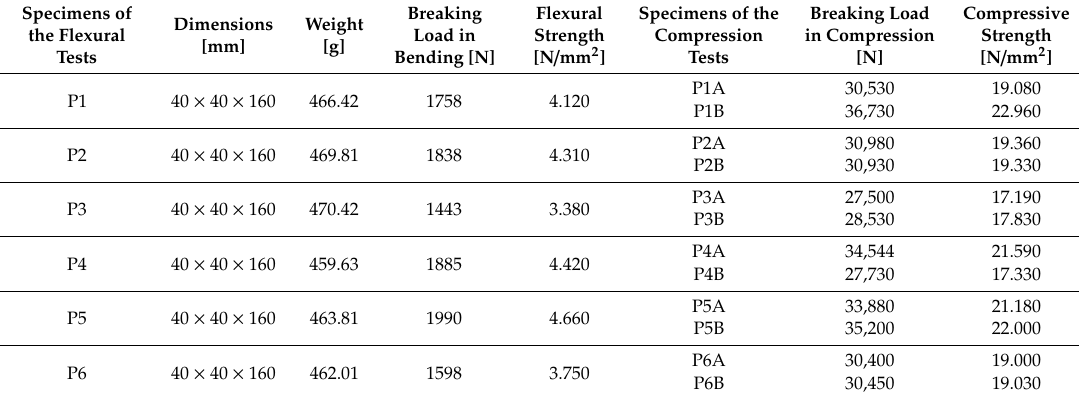
Table 2. Characteristics of the mortar specimens tested according to UNI EN 1015-11 / 2007 [1]. Specimens of the